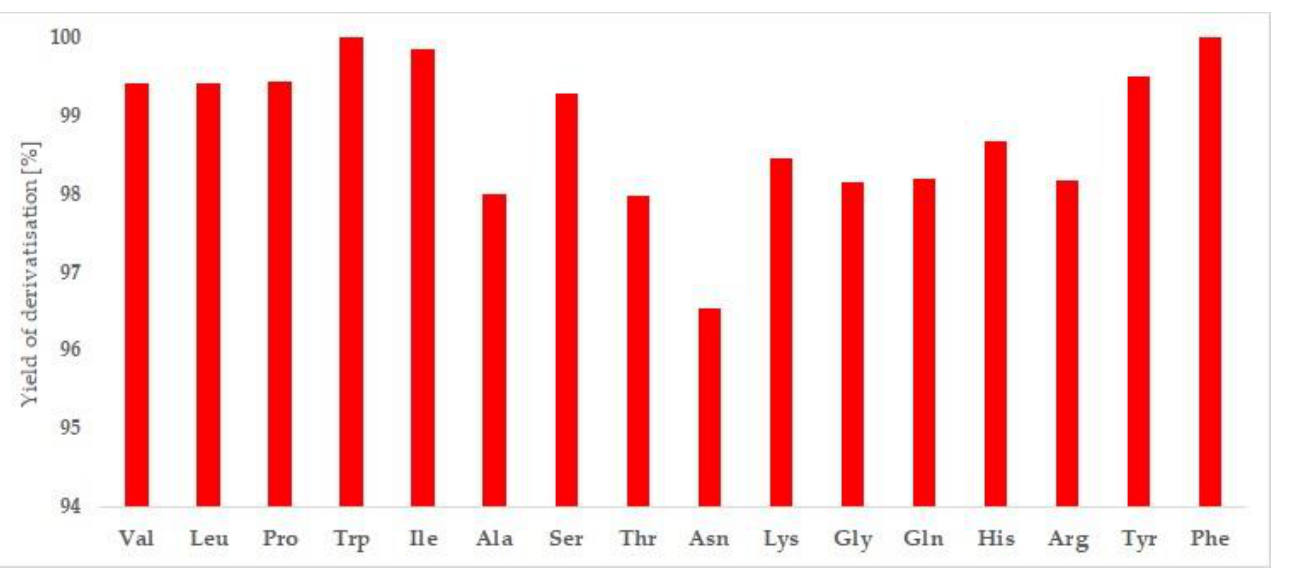
Figure 2. The yield of the amino acid derivatives with FNBT.